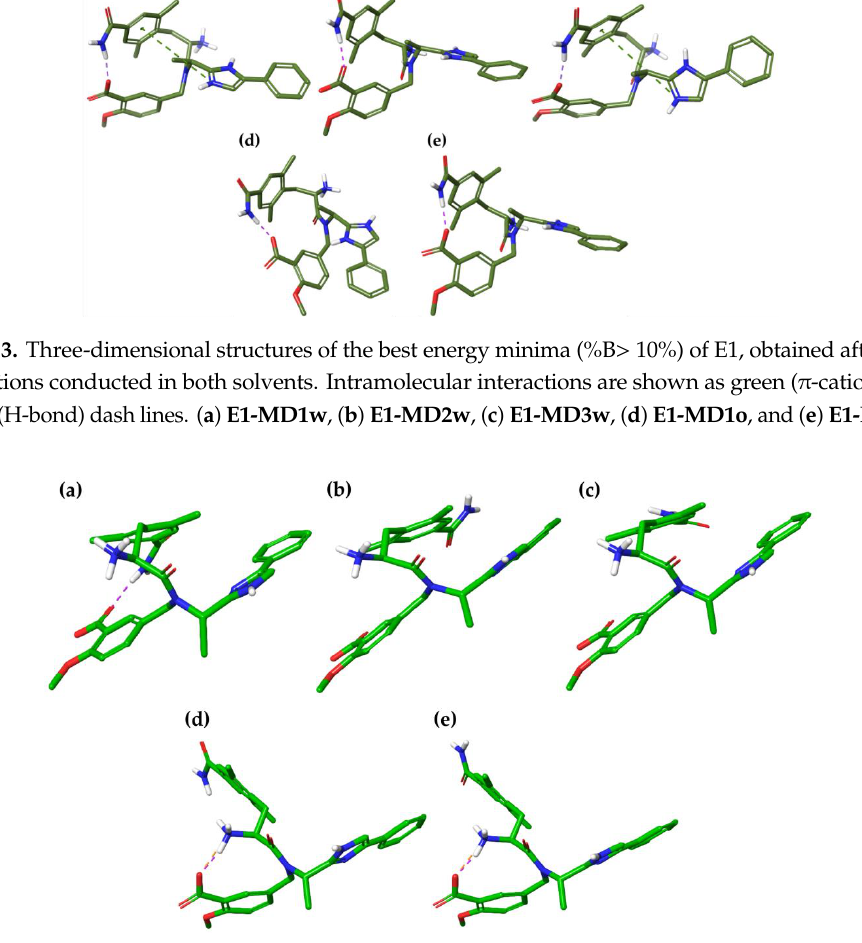
Figure 4. Three-dimensional structures of the best energy minima (%B > 10%) of E2, obtained after MD simulations conducted in both solvents. Intramolecular interactions are shown as green (π-cation) and purple (H-bond) dash lines. ( a ) E2-MD1w , ( b ) E2-MD2w , ( c ) E2-MD3w , ( d ) E2-MD1o , and ( e ) E2-MD2o. Table 7. %B, RMSd values and intramolecular interactions of the most probable energy minima for E2, obtained after the minimization of all MD frames in both solvents. RMSd values are reported in Å, and they are calculated on the heavy atoms of E2 compared to the global energy minima ( E2-MD1w and E2-MD1o